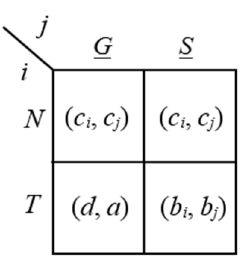
Figure 13. Trust Minigame as original game G